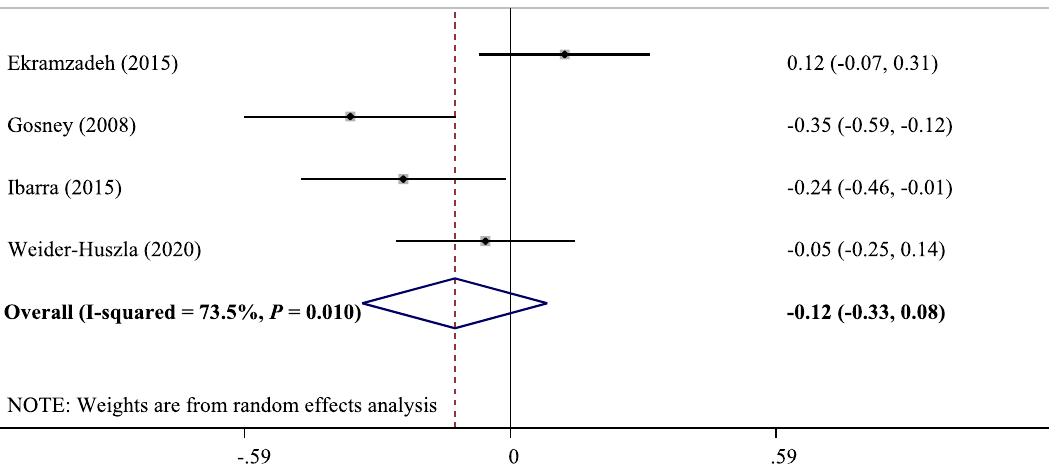
Figure 2. Forest plot of the correlation between serum selenium levels and depression scores.